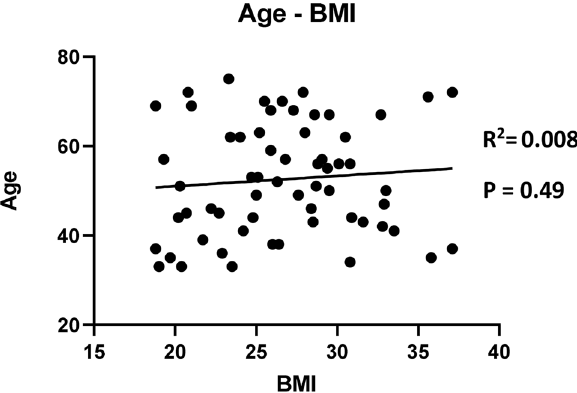
Figure 1. Correlation between age and BMI of patients (N = 62).